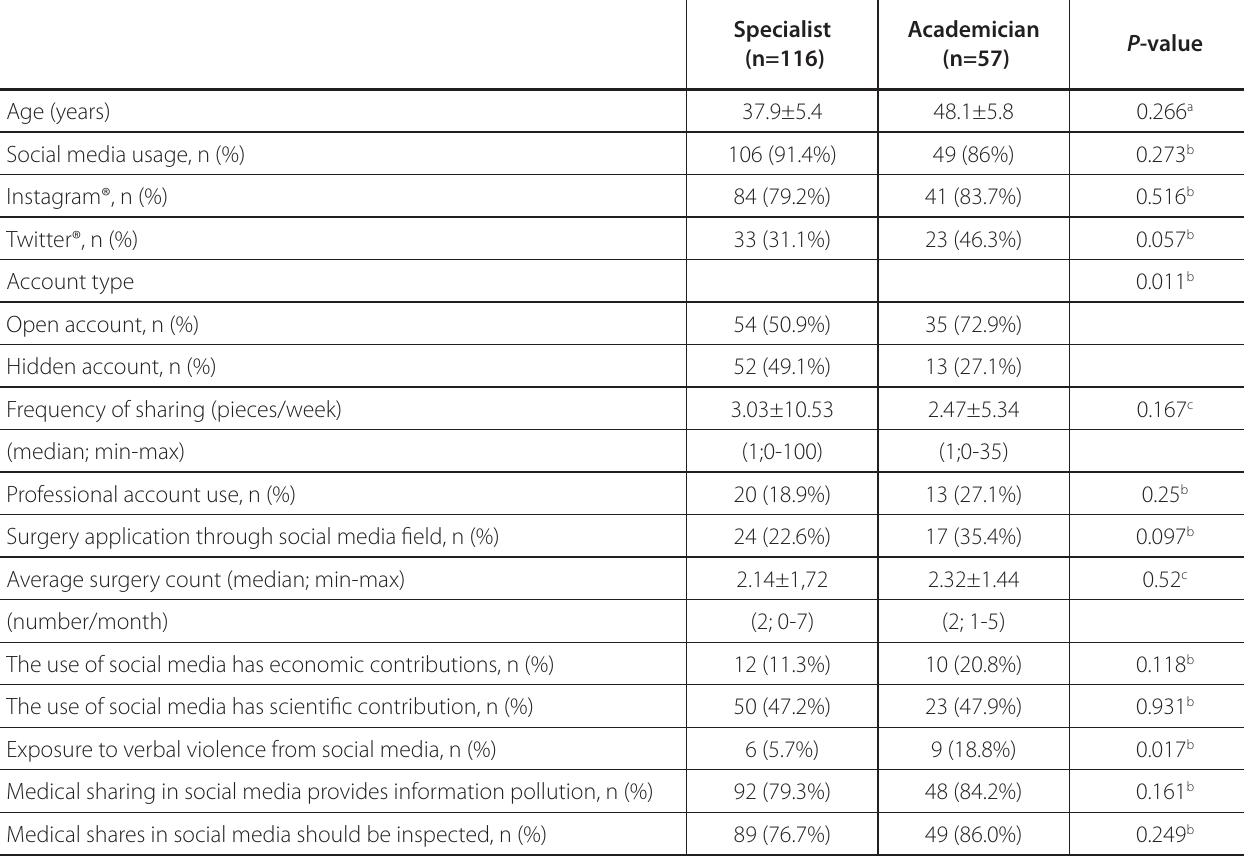
Table 3 . Results among cardiovascular surgeons according to the working